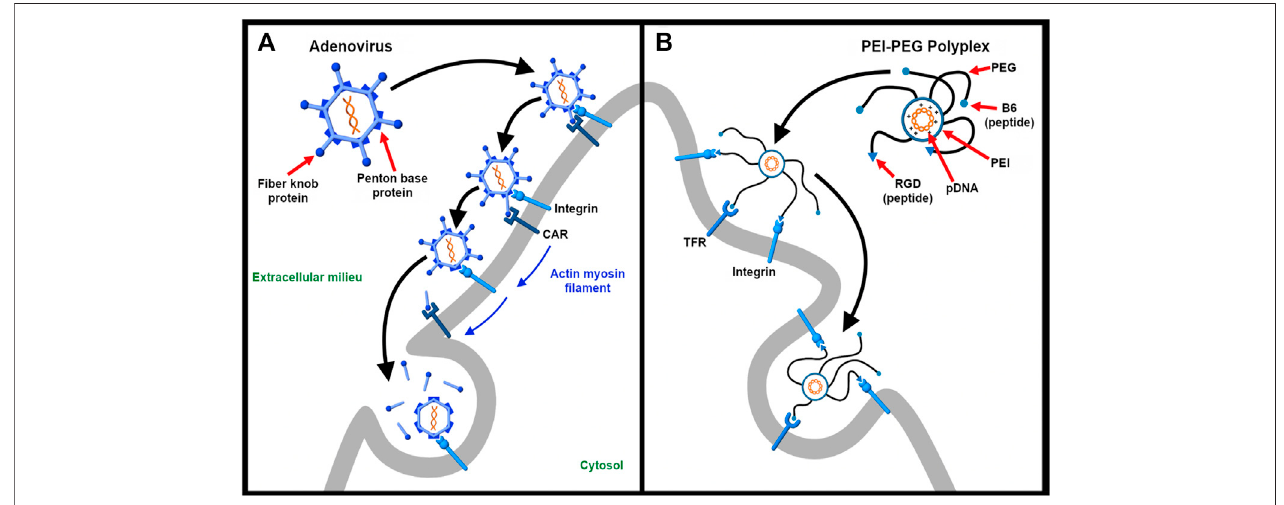
FIGURE3| Targetingmultiplereceptorsenhancescellularspeci fi cityandtransfectionef fi ciency. (A) .Theentryofadenovirusintothehostcelloccursinathree-step process – binding, drifting, and shedding. First, the adenovirus binds to the Coxsackievirus and adenovirus receptor (CAR) of the host cell surface through fi ber knobs jutting out the vertices of the icosahedral shaped viral capsid. Second, acto-myosin drifting of the virus-bound CAR receptor leads to internment of the penton base protein of the viral capsid by integrins expressed on the cell surface. Third, the slow drifting motion (0.1 μ m/s) of the CAR receptor and the stable nature of binding causes mechanical stress onto the viral capsid, the fi rst uncoating step in the capsid disassembling process. The protein VI of the inner capsid is exposed which makes lesions in the plasma membrane and undergoes integrin-dependent endocytosis (Burckhardt et al., 2011) (B) . As described by Nie et al. (Nie et al., 2011), a synthetic dual-ligandtargeted vectorsystemwasconstructed usingacationicpolymerPEI todeliverpDNA. PEGmoieties wereusedtoshieldthechargeofthepolyplex.Inspired fromnaturalviruses,thepolyplexwasconjugatedwithTransferrinreceptor(TFR)-bindingB6peptideandintegrin-recognizingRGDsequencefordualtargetingpurpose. Thereceptorspeci fi cityofthedualtargetedpolyplexshowsincreasedgenetransfectionascompared tothesingletargetingpeptide. Theintegrinreceptorbindinghelps in cellular association and the vector is internalized via TFR-mediated endocytosis.